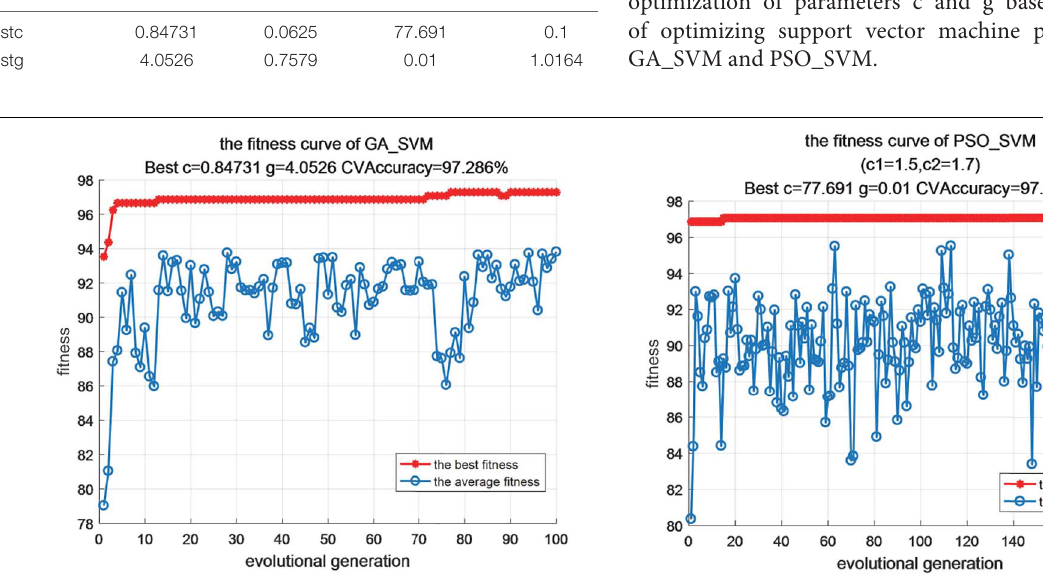
FIGURE 2 | The visualization of iterative